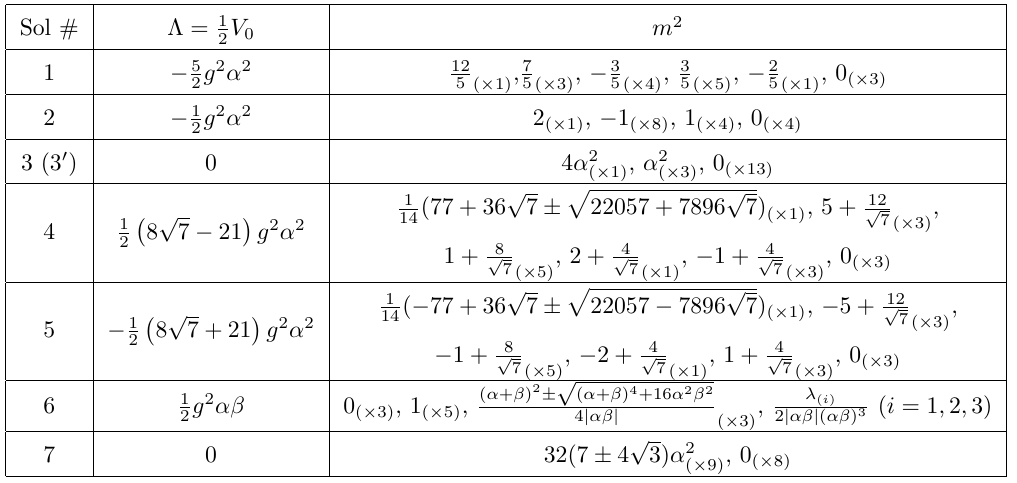
Table 13 . Potential and mass eigenvalues for the critical points of the scalar potential induced by the compacti(cid:12)cation of mIIA with KKO5/KK5. In this case, we obtain two families of Mkw vacua, 3 families of AdS vacua, a 1-parameter family of dS solutions and a 2-parameter family of (A)dS solutions. Solution 1 is the supersymmetric AdS vacuum found in [40]. When the poten- tial is nonvanishing, the mass eigenvalues are normalized by j (cid:3) j . In D = 6 AdS spacetime, the Breitenlohner-Freedman bound reads m 2 = (cid:0) 5 j (cid:3) j BF 8